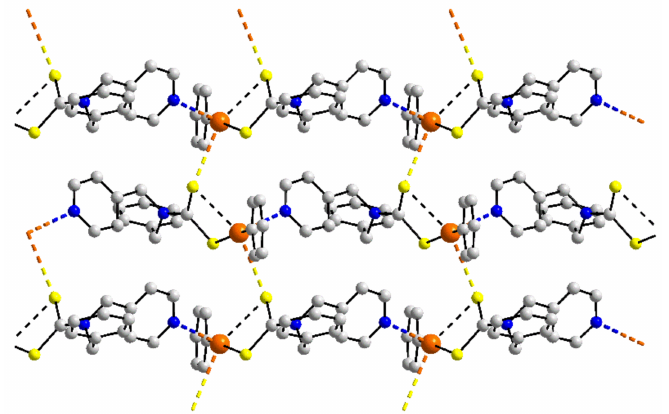
Figure 24. Supramolecular layer in the crystal of 61 whereby a linear coordination polymer is linked into a two-dimensional array by Hg ··· S interactions.